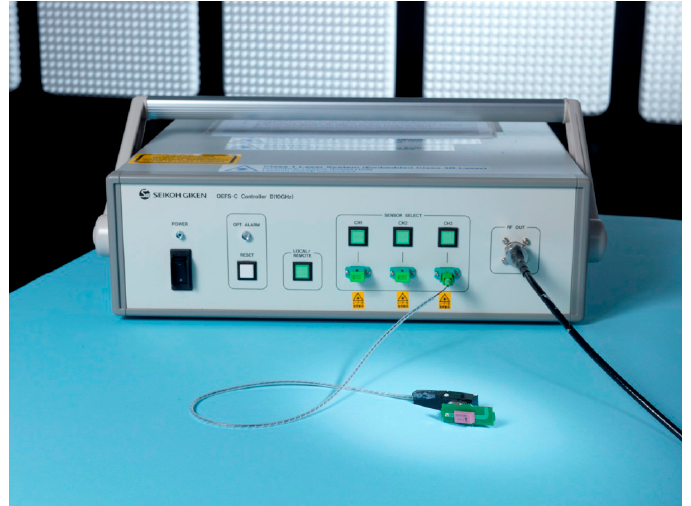
Figure 2. The dielectric resonator antenna (DRA) antenna connected directly to the opto-electric fibre